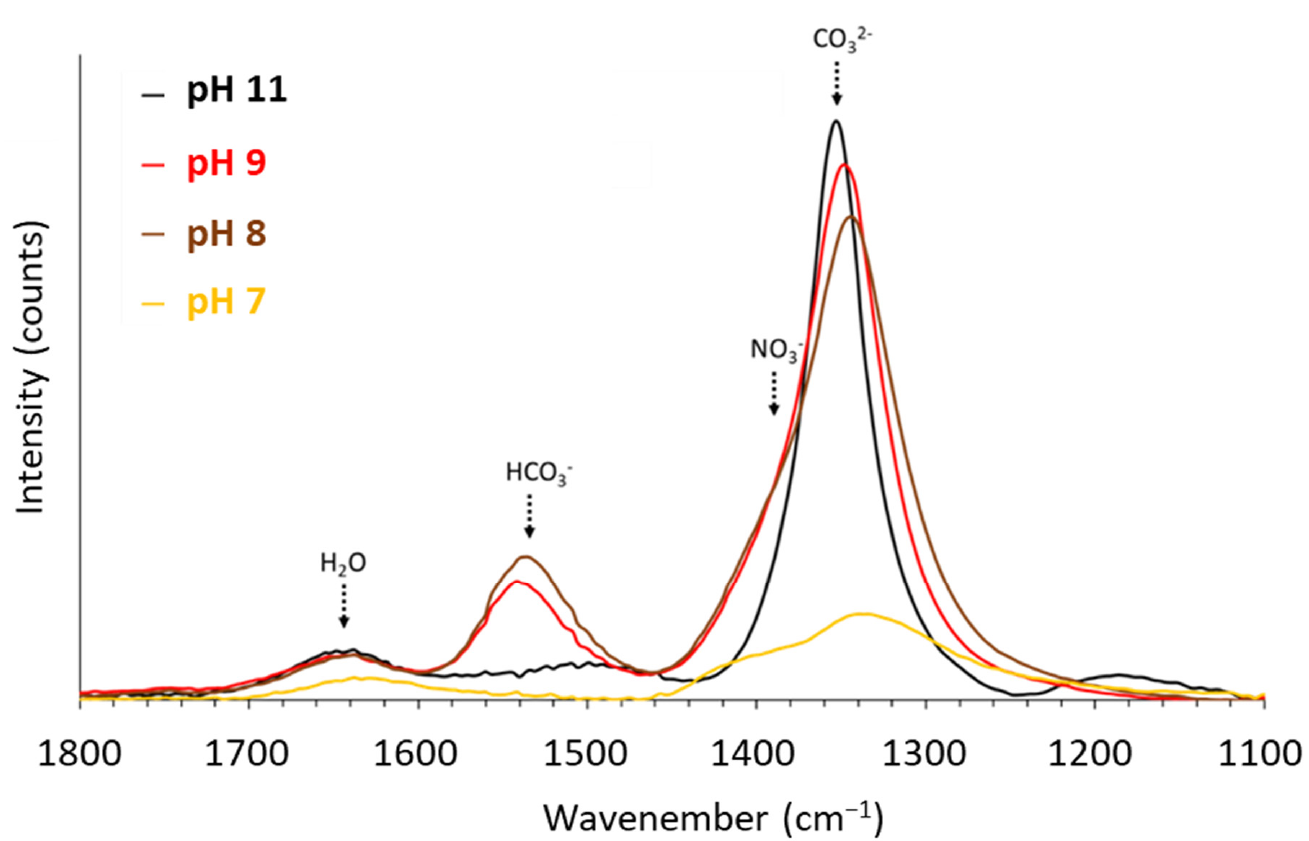
Figure 7. FTIR spectra obtained for the solid collected after the titrations were carried out until reaching pH values 7, 8, 9 and 11.